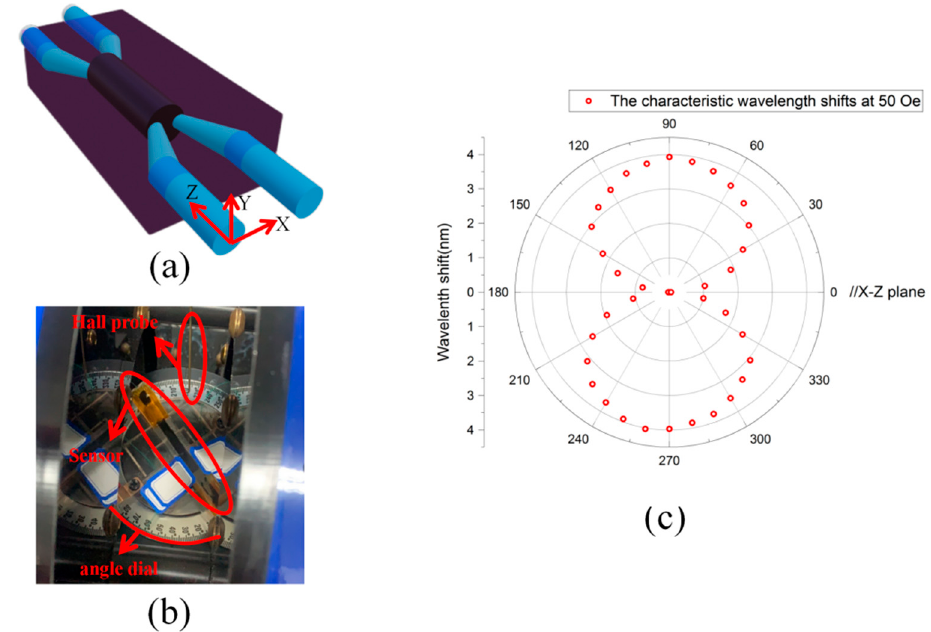
Figure 8. ( a ) The sensor is placed in a Helmholtz coil with an angle dial. ( b ) The experiment meas- ured the shifts of characteristic wavelength for different magnetic field vectors at 50 Oe. ( c ) Characteristic wavelength shifts when the rotation angle changed from 0° to 360° at 50 Oe in the X-Z plane.